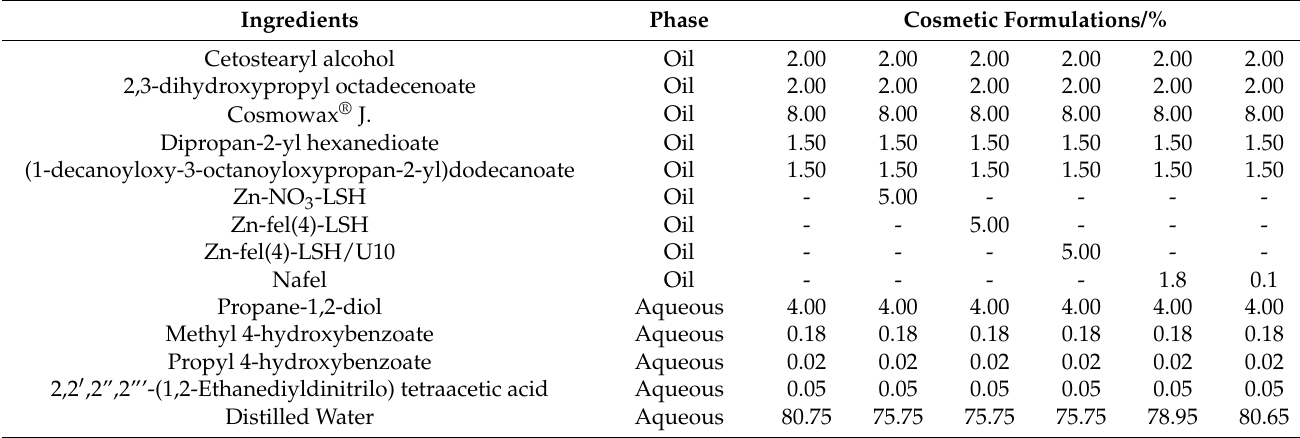
Table 6. Mass percentage of formulation ingredients of cosmetic creams containing Zn-NO 3 -LSH, Zn-fel(4)-LSH, Zn-fel(4)- LSH/U10, or Nafel (NaC 10 H 9 O 4 )